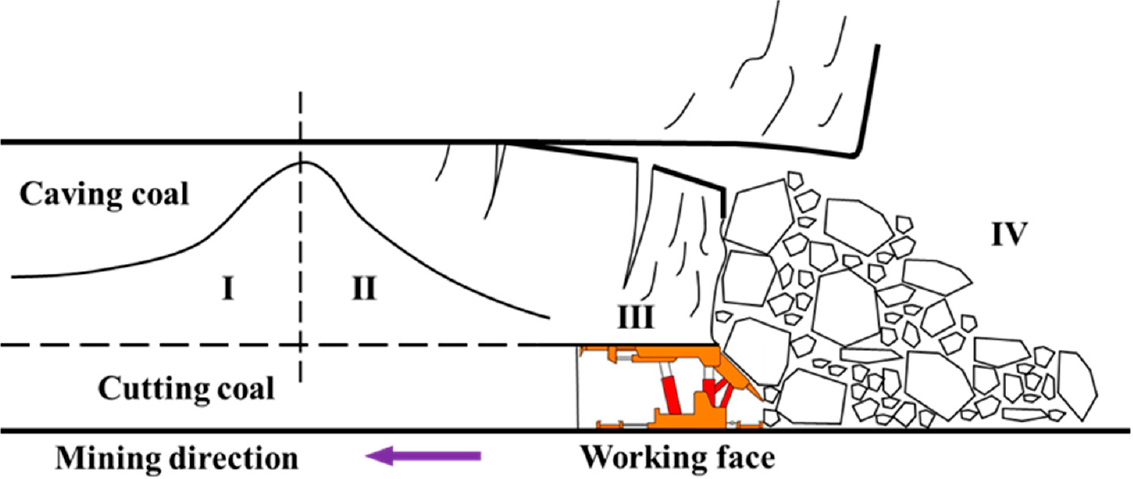
Figure 5. Natural destruction process of top coal caving.